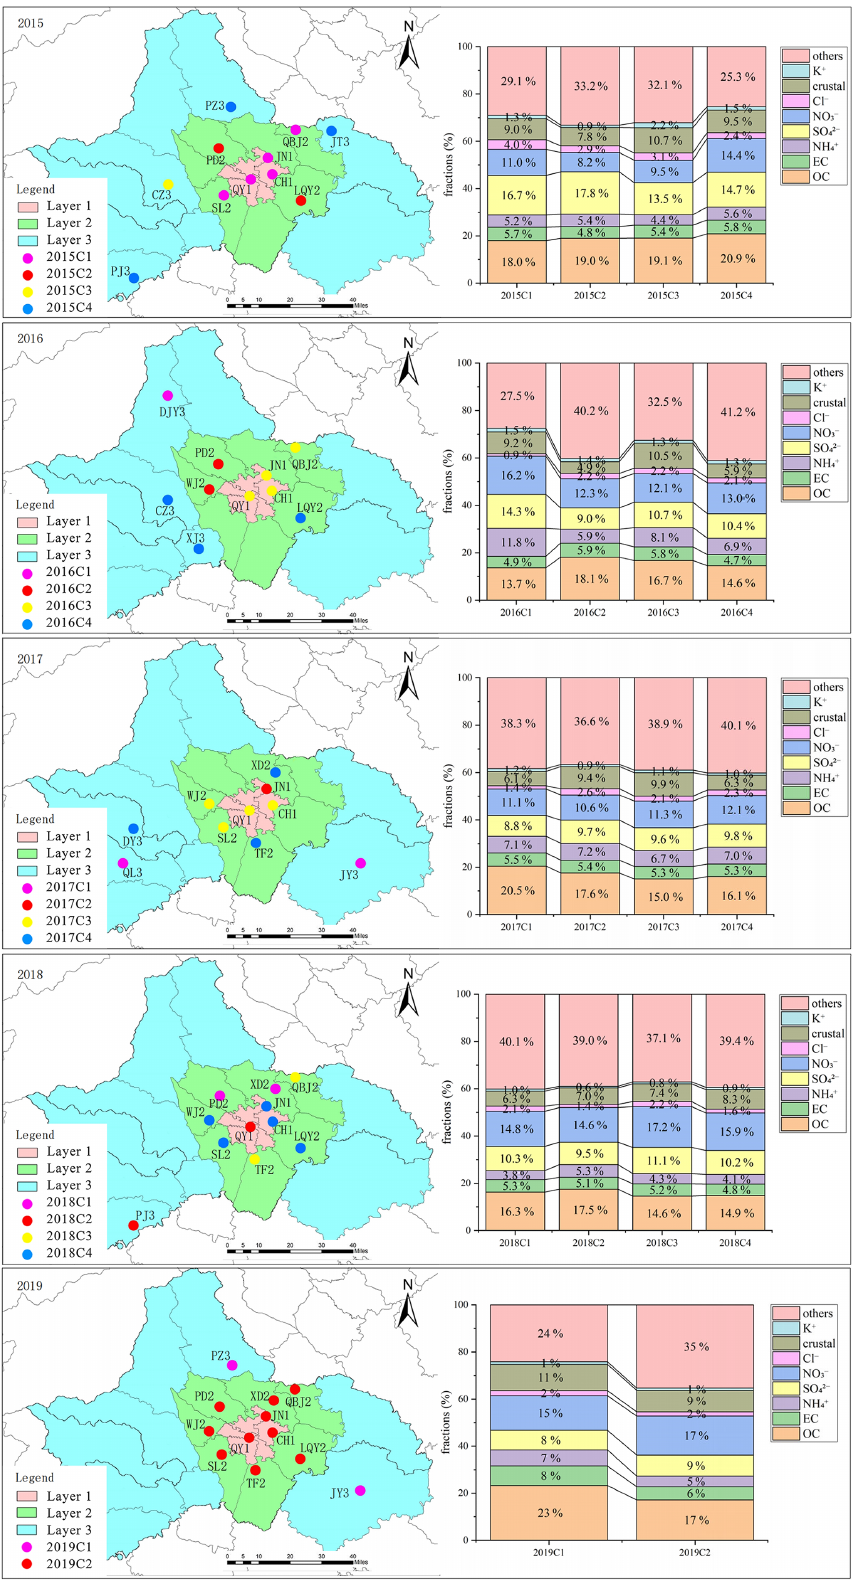
Figure 5. Spatial distribution of PM 2 . 5 compositions and fraction values of each cluster from 2015 to 2019. (i.e. 2015C1 refers to the first cluster of sampling sites in